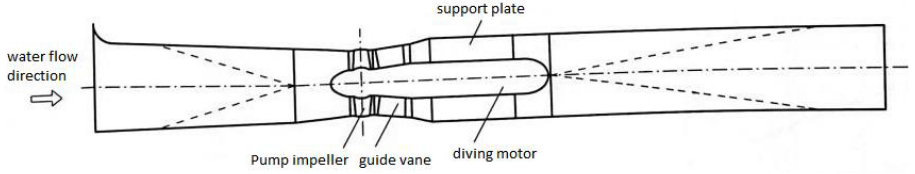
Figure 3. Submersible pump device (rear motor submersible tubular pump device) [8].